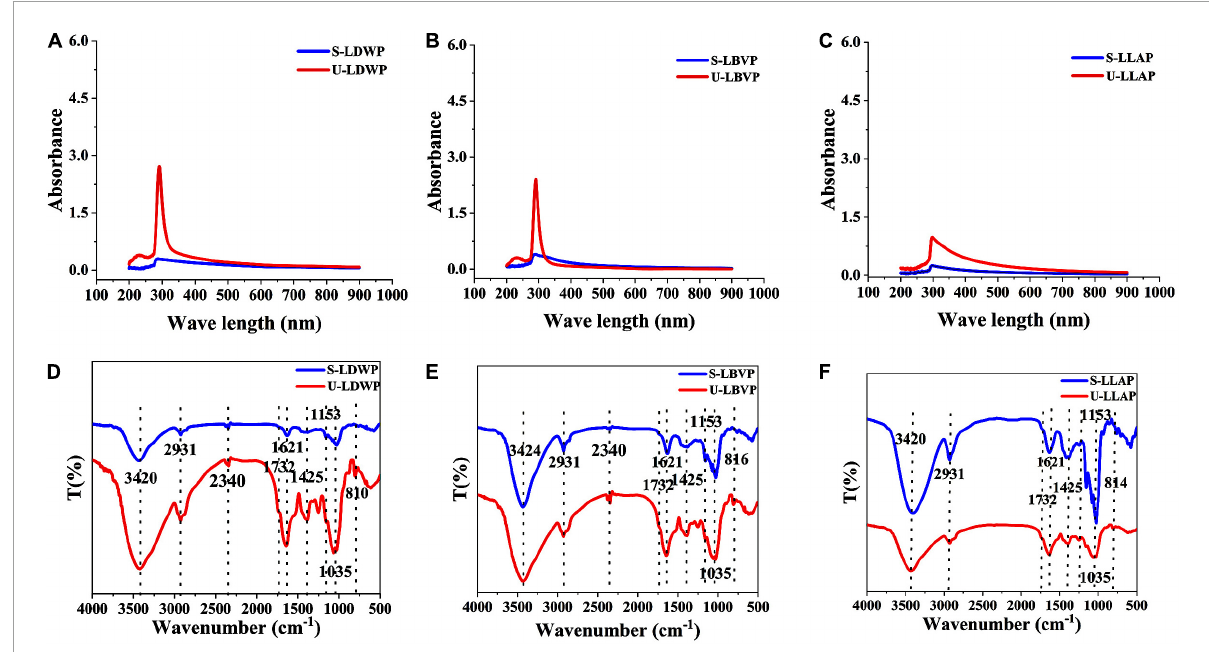
FIGURE3 Spectrum properties of three lily polysaccharides extracted by different extraction methods. (A–C) The ultraviolet–visible (UV) analysis. (D–F) Fourier transform infrared (FT-IR)